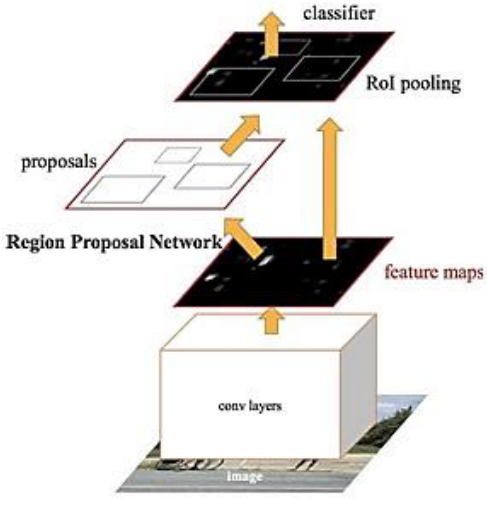
Figure 3. Faster R-CNN [39].